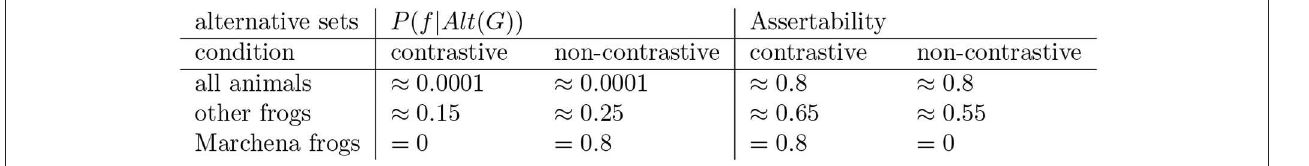
FIGURE 7 | Assertability values for different alternative